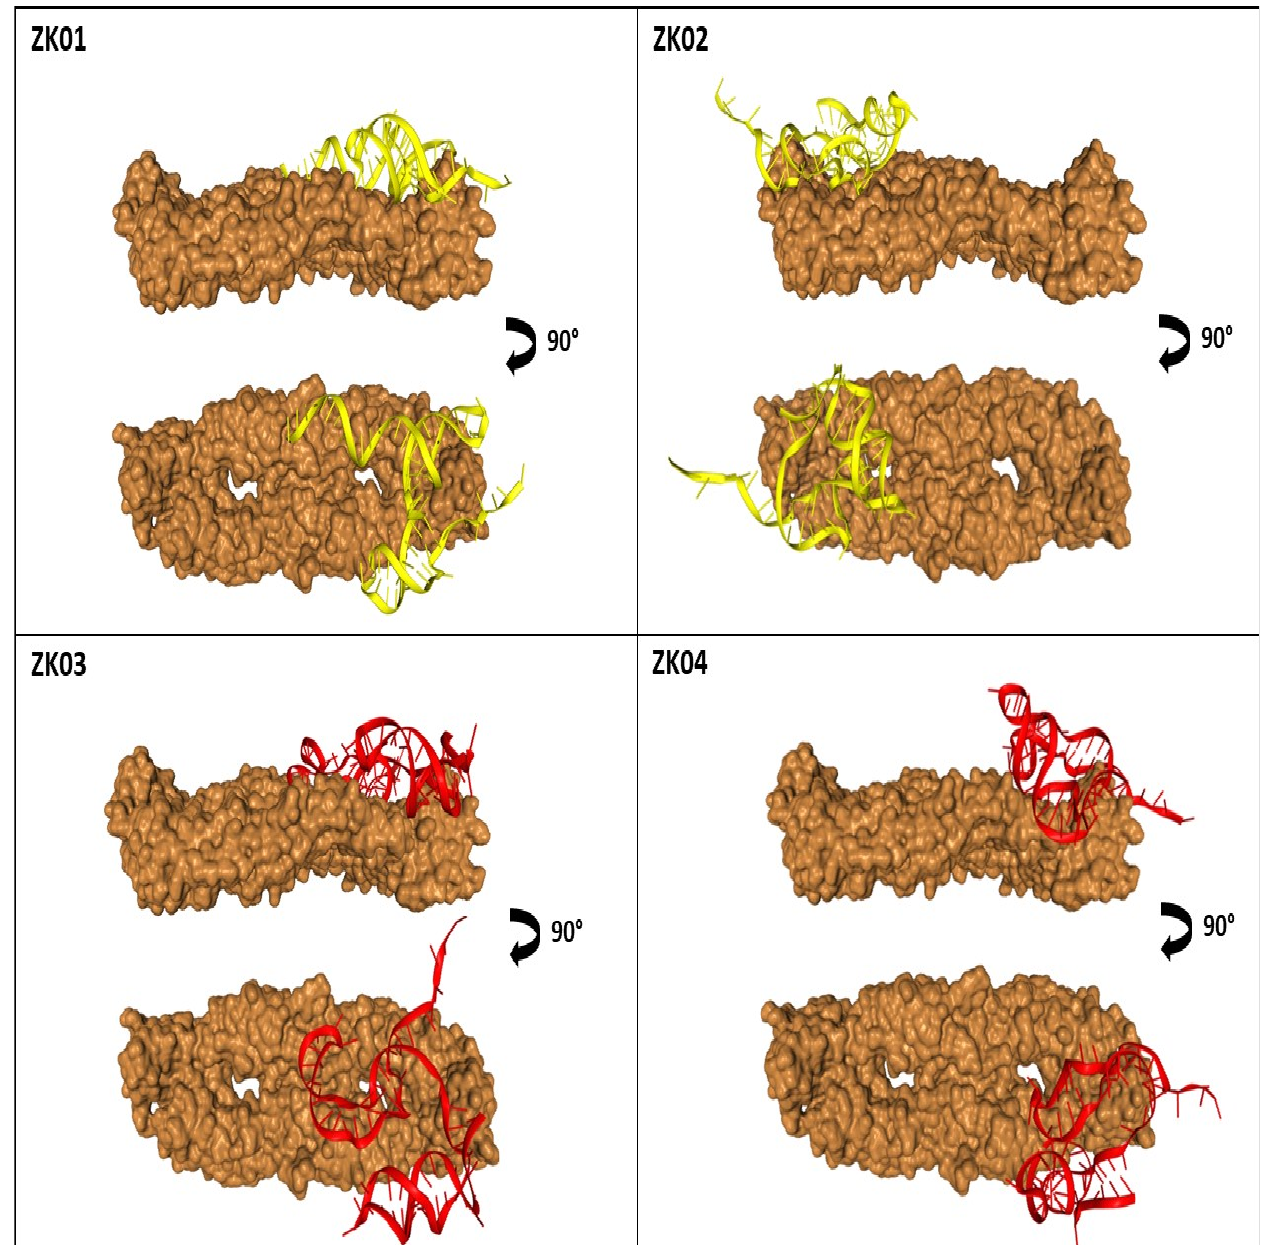
Figure 8. Molecular dynamics simulation of the selected aptamers and dimeric ZIKV E protein by the HDOCK server. Protein E is represented at two angles: the first, showing the aptamer binding on the outside of the protein; the second, with a 90° rotation, detailing the exact location of interaction.